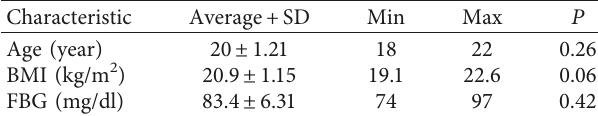
Table 2: Research subjects’ characteristics.